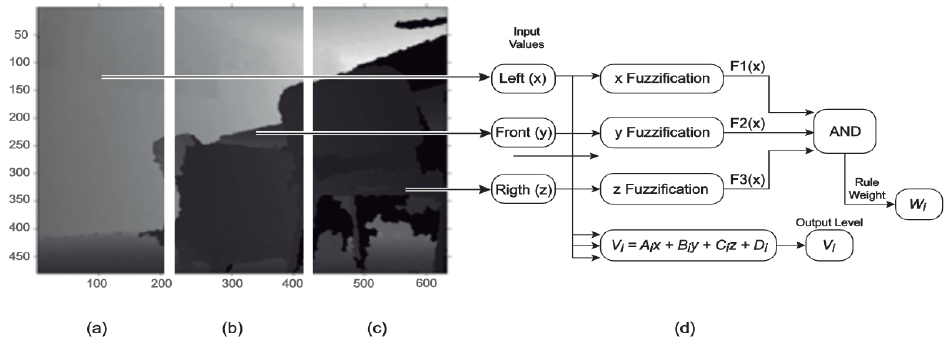
Figure 6. ( a ) Left Subimage; ( b ) Center Subimage; ( c ) Right Subimage; and ( d ) Fuzzy logic system. The module implements the method proposed by [29], computing the threshold value and differentiating high and low depths. For each sub-image, if the amount of unknown data (0-values) is more considerable than a given percentage (67% in this case), the sub- image data suggest nearby obstacles, and the average depth is computed by using the mean of the low-valued depths. Otherwise, the average depth is computed by using the mean of the high-valued depths. If there are no low-valued depths, then the high-valued depths are used. In a few words, the average depth in each sub-image provides the region with a lower probability of collision, and if this region is not determined, then the robot is